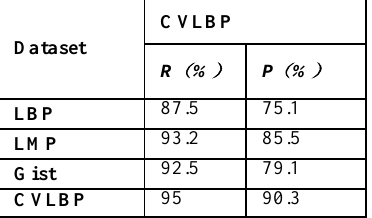
Table 1. Comparison Result of Ship Target